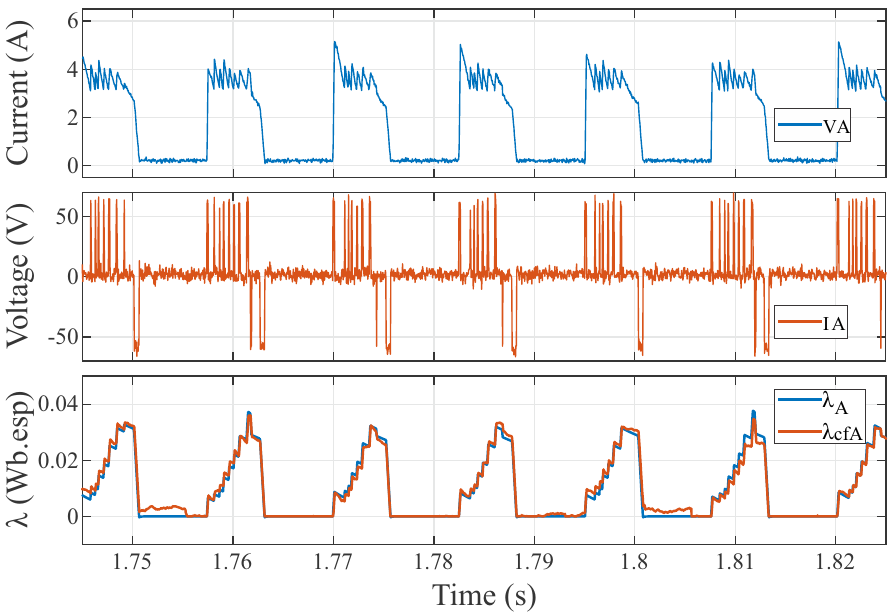
Figure 8. Simulation results of the proposed drift cancellation